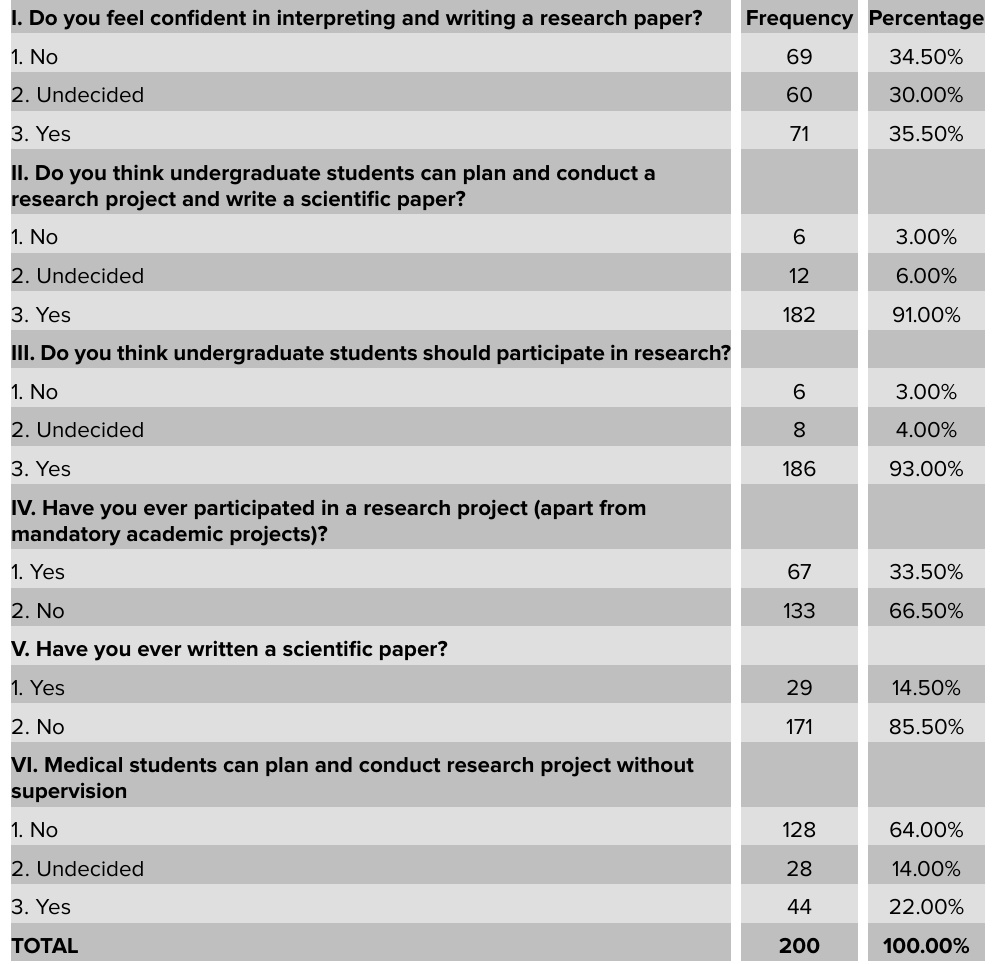
TABLE 2: Responses of the fifth- and sixth-year medical students to attitude